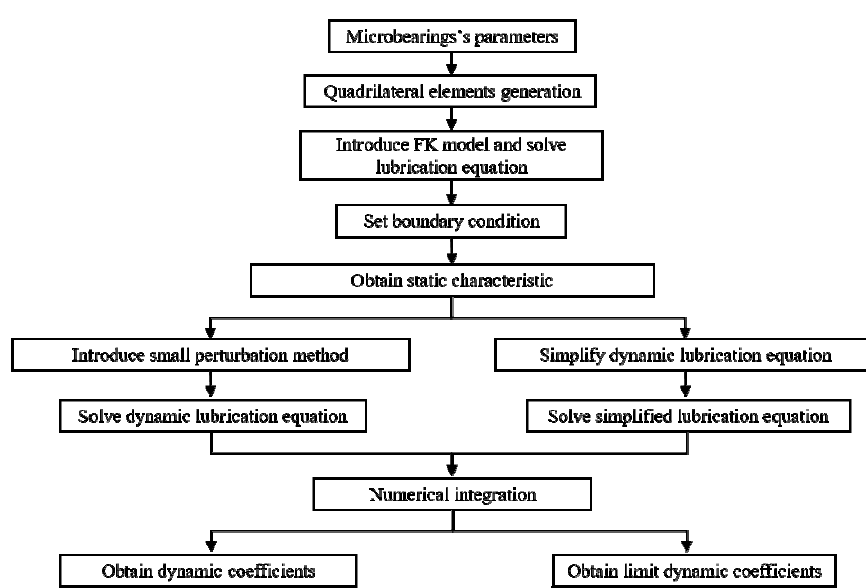
Figure 2. Flow chart of solution.